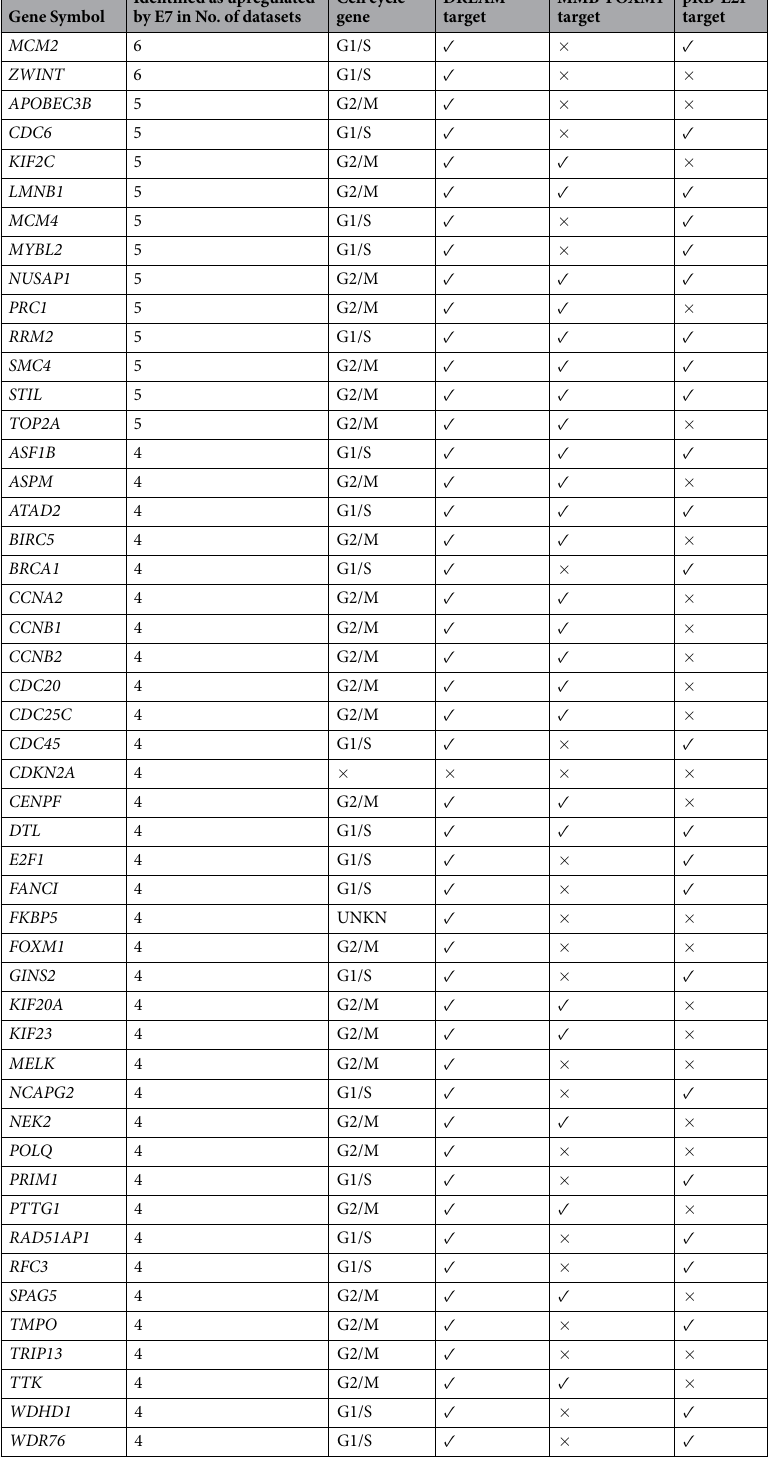
Table 2. HPV E7-deregulated genes with an identification-overlap of at least four out of six datasets. 49 genes were identified in at least 4 of the 6 datasets as being deregulated by HPV E7 (compiled from Table S1). Annotation of cell cycle genes, including the phase of peak expression and DREAM, MMB-FOXM1 or pRB-E2F targets were extracted from Fischer et al . 23 . UNKN, timing of peak expression of the cell cycle gene is unknown; X, cell cycle-dependent expression was not reported in the